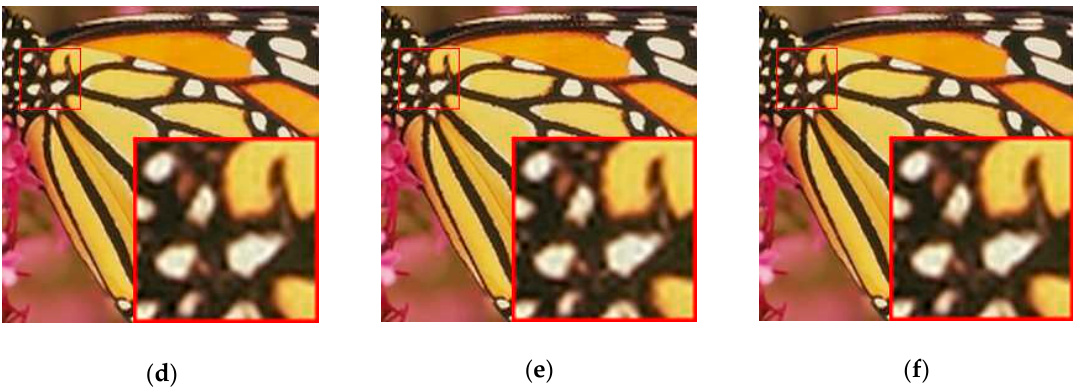
Figure 6. SR results of the image Butterfly by different methods. ( a ) Original image. ( b ) Bicubic interpolation (BI). ( c ) Soft-decision-adaptive interpolation (SAI). ( d ) CSC. ( e ) LMCSC. ( f ) SCCSL.